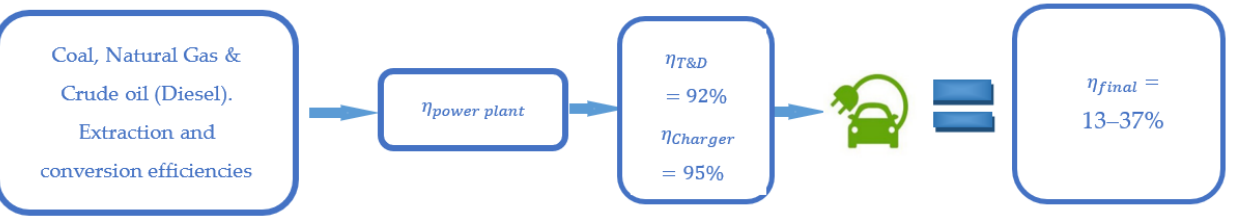
Figure 4. The final efficiency of EVs’ charging considering the electricity coming from power plants.